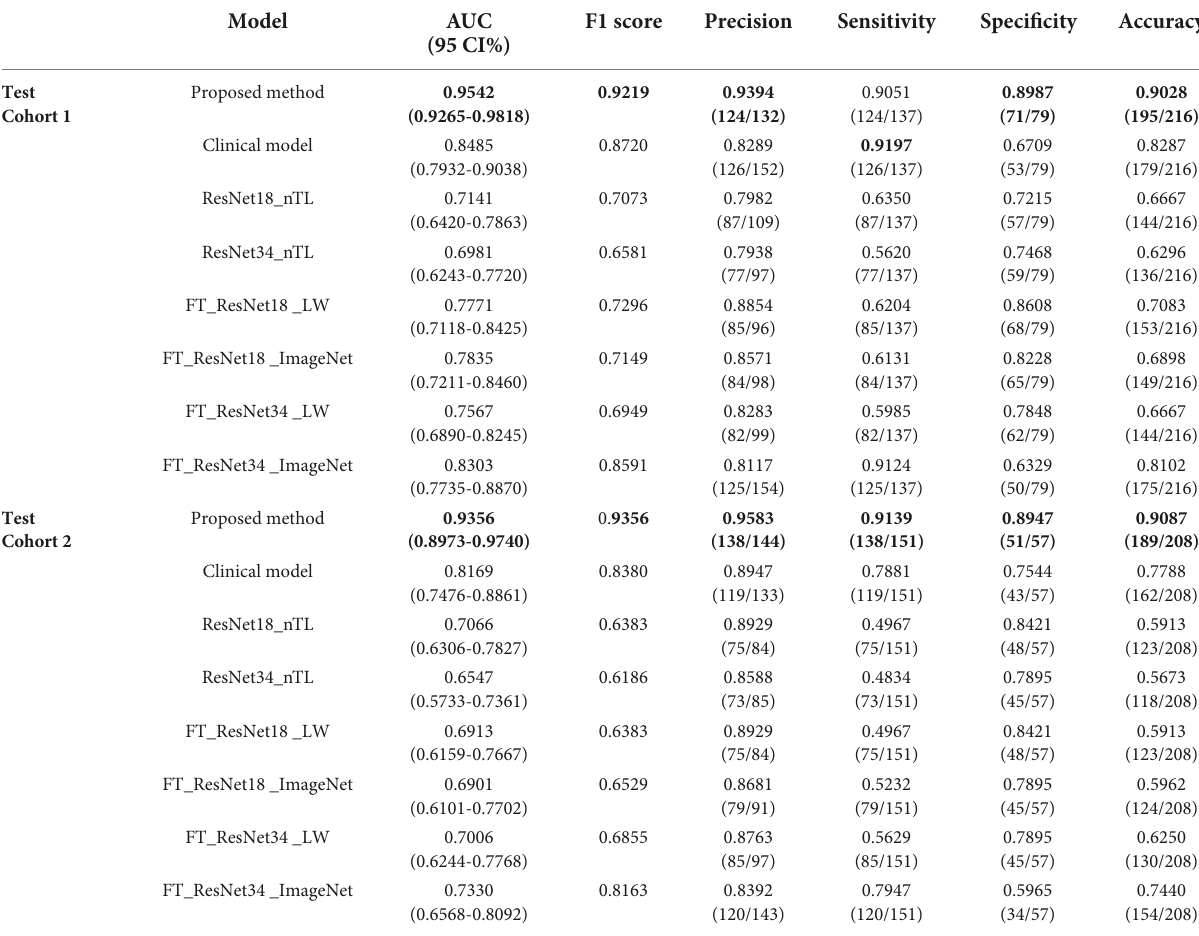
method was more effective than the seven traditional methods. Table 2 presents the classification performance indicators of each model. The results of the proposed method (AUC: 0.9542 and 0.9356, F1 score: 0.9219 and 0.9356, and accuracy: 0.9028